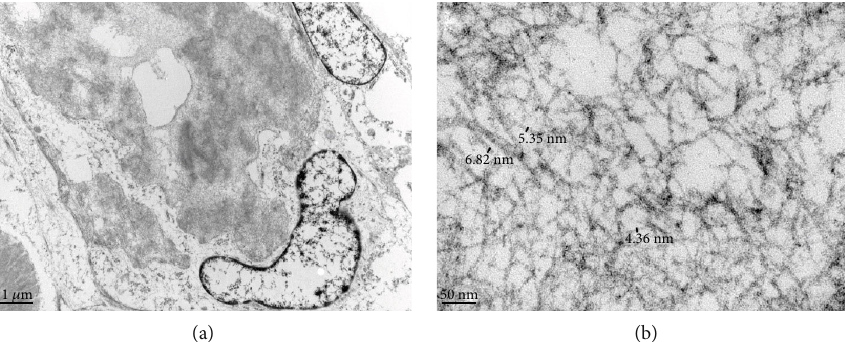
Figure 3: Electron microscopy: (a) electron-dense amyloid-like material ( scale bar = 1 micron); (b) fi brils measuring 4-7nm in diameter observed at higher magni fi cation ( scalebar = 50